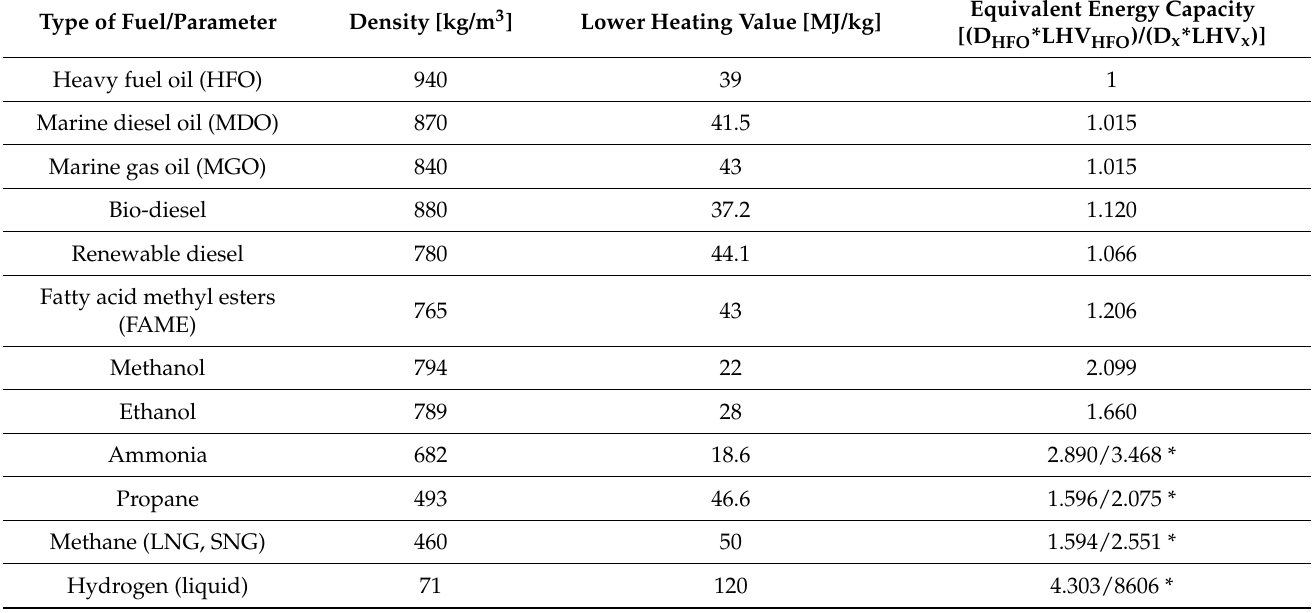
Table 1. Comparison of equivalent energy capacity of fuel in vessel’s tanks (for HFO = 1) (own elaboration).